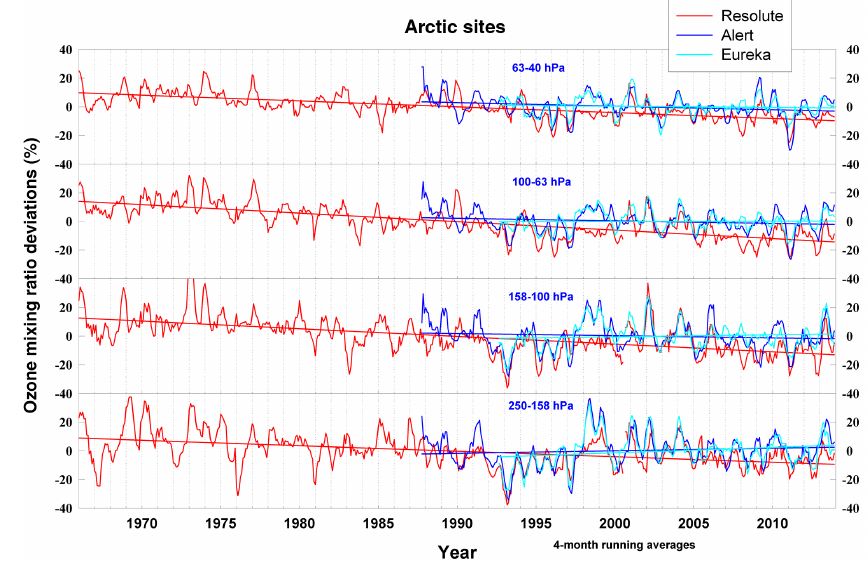
Figure 12. As Fig. 11, for the three Arctic stations. The overall station trend lines are shown.